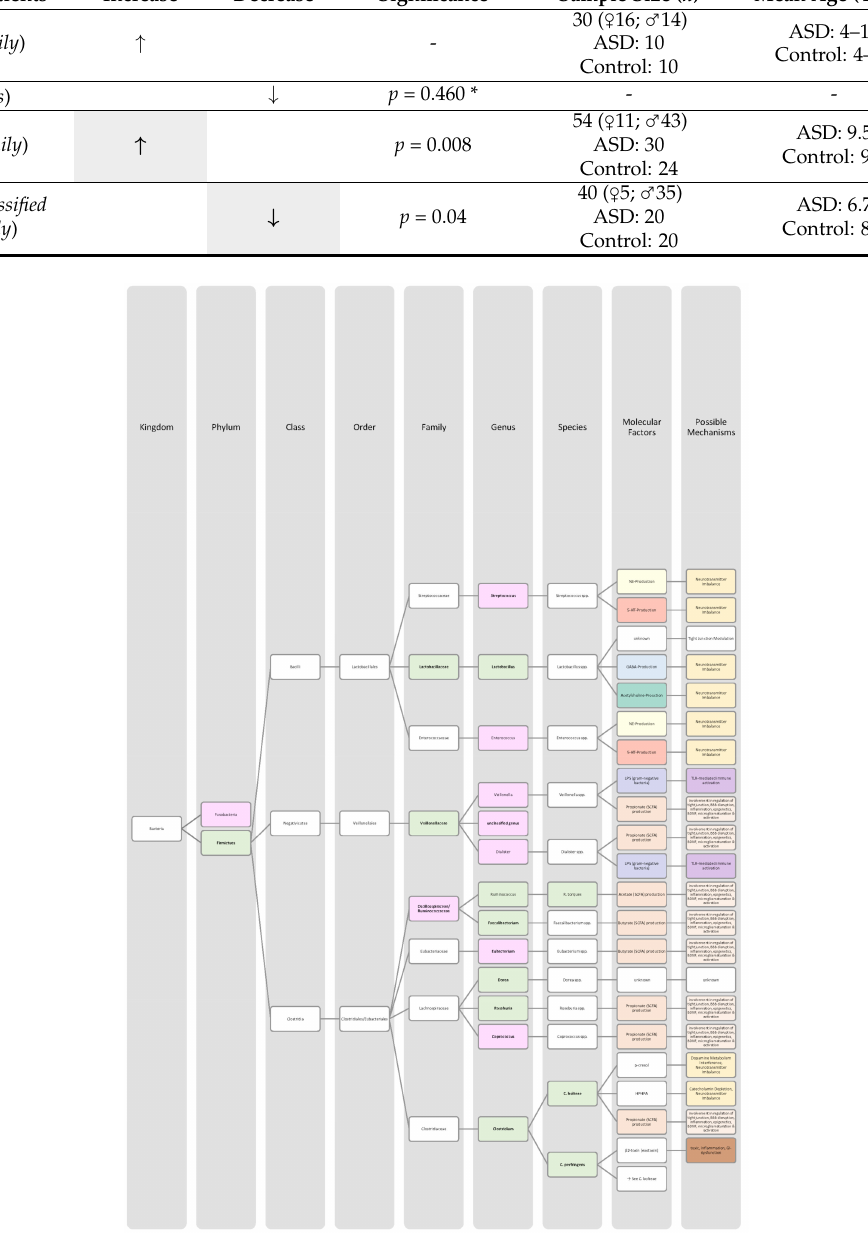
Figure 3. Part 1 of visual representation of the changes in microbiota composition in autism spectrum disorder patients from Table 3. For an explanation, see the legend of Part 2 in Figure 4. Concentrations of free aromatic amino acids phenylalanine, tryptophan, and tyrosine were increased in faeces of ASD individuals [46]. Different bacterial metabolites showed altered patterns in ASD children compared to healthy controls. Two of them are the metabolic by-product of Clostridia : 3-(3-hydroxyphenyl)-3-hydroxypropionic acid (HPHPA) (an abnormal phenylalanine metabolite) and para-cresol (p-cresol) (which derives from tyrosine metabolism). Increased HPHPA and p-cresol were consistent with the higher Clostridium abundance [3,47]. HPHPA can potentially deplete catecholamines in the brain, such as dopamine, adrenaline, and noradrenaline produced by the adrenal gland. This is believed to contribute to typical ASD symptoms such as hyperactivity and stereotypical behaviour [46,47]. P-cresol has also been associated with repetitive behaviour patterns